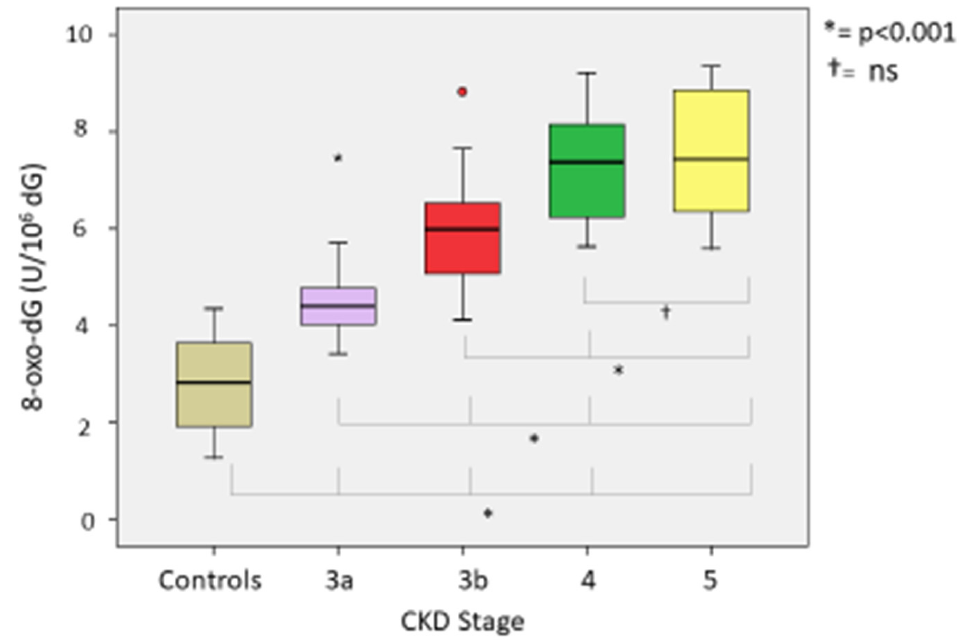
Figure 6. 8-oxo-dG in different stages of